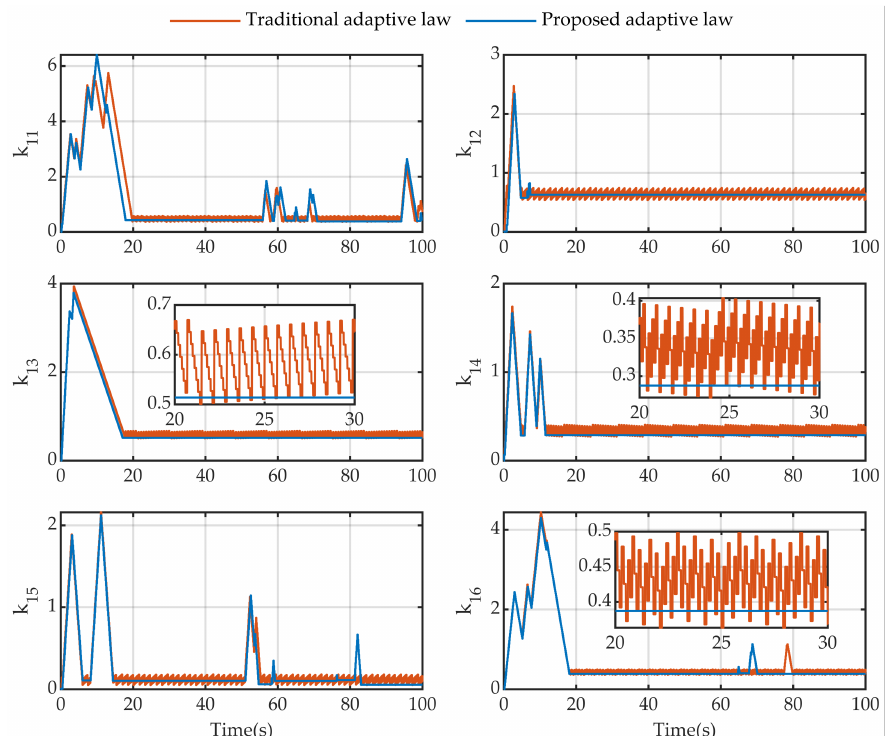
Figure 10. Comparison of adaptive gains between the traditional and proposed adaptive